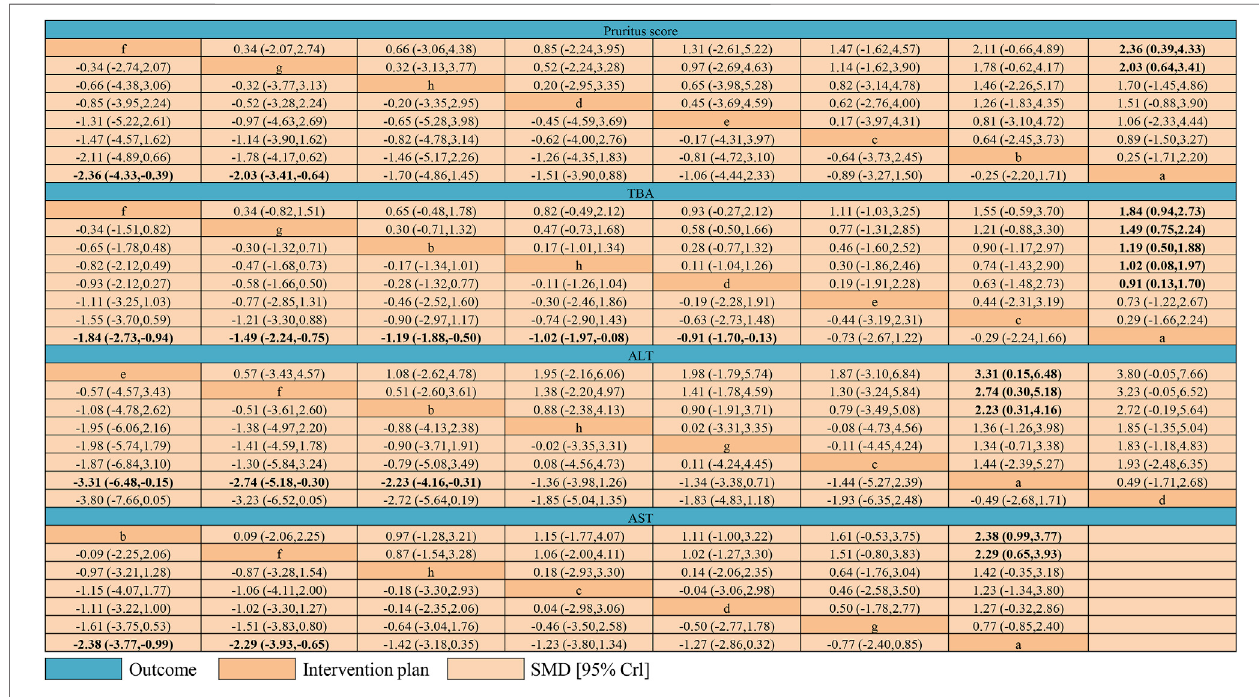
FIGURE 7 | League table of network meta-analysis of pruritus score, TBA, ALT, and AST. Intervention plans are in order of each outcome ranking basing on SUCRAs. The table should be read from the top left to the bottom right. Notes: a: UDCA, b: Yinzhihuang oral liquid + UDCA, c: salvia injection + UDCA, d: Yinchenhao decoction + UDCA, e: the change of Yinchenhao decoction 1 + UDCA, f: the change of Yinchenhao decoction 2 + UDCA, g: the change of Yinchenhao decoction 3 + UDCA, and h: other traditional Chinese medicine prescriptions + UDCA.